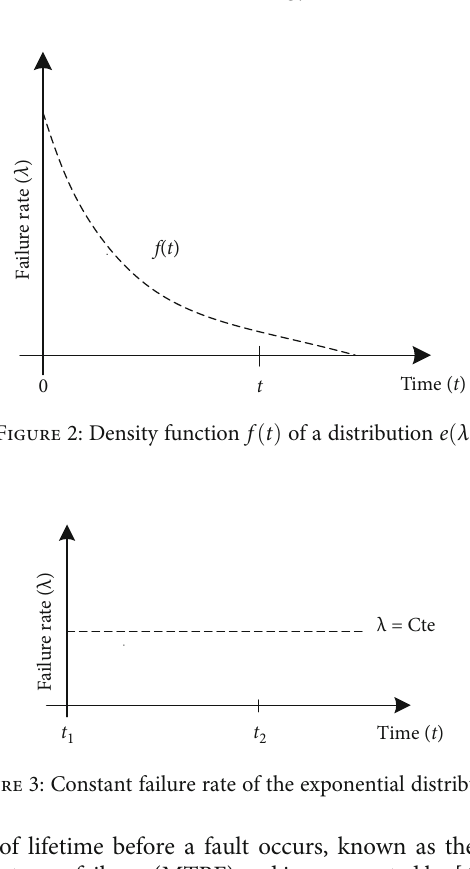
Figure 4: Reliability block diagram of a serial